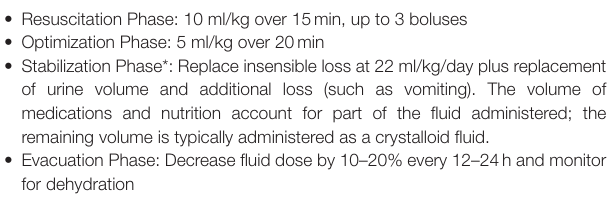
TABLE 2 | Fluid dose